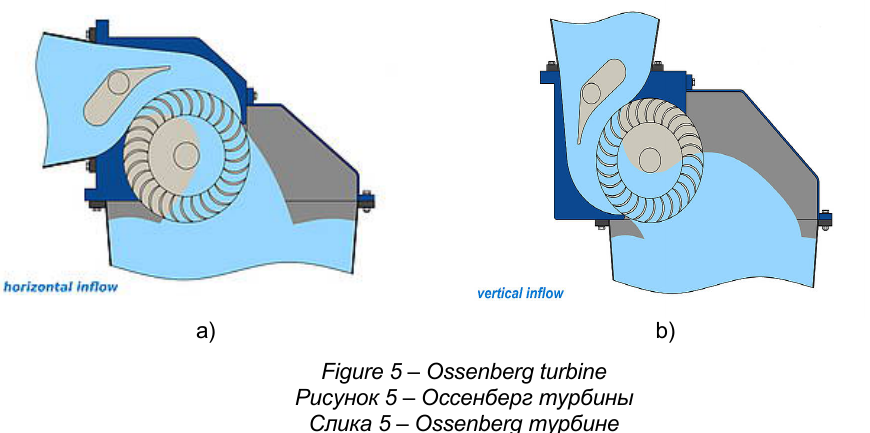
Figure 5 – Ossenberg turbine Рисунок 5 – Оссенберг турбины Слика 5 – Ossenberg